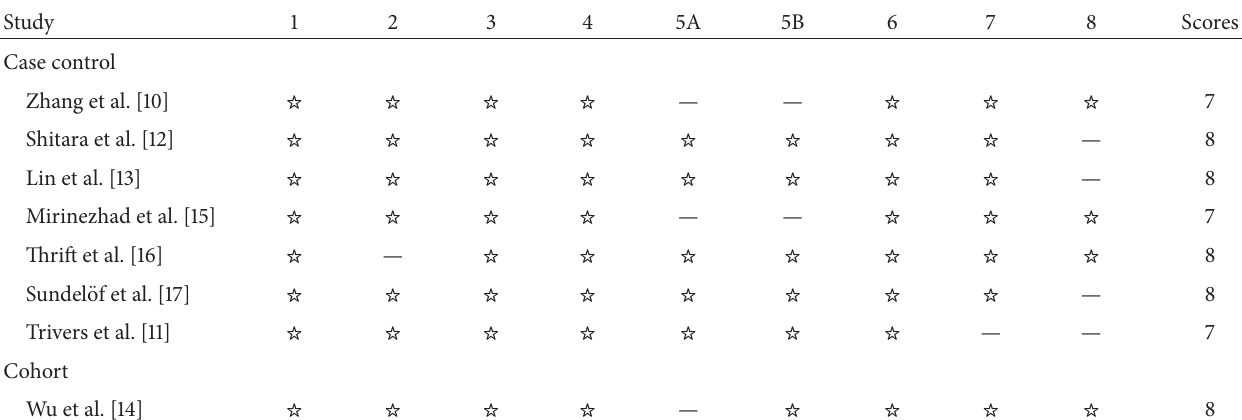
Table 3: Results of quality assessment by Newcastle-Ottawa Scale.